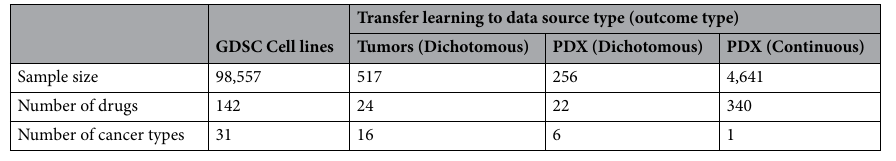
Table 1. Datasets used in this